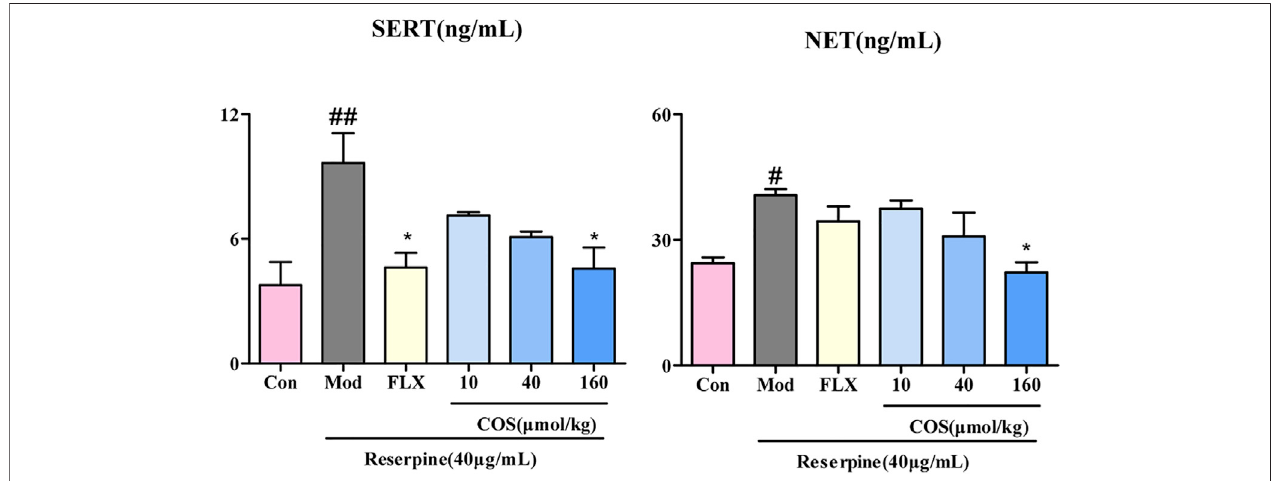
FIGURE7| Potentialmechanism ofthe antidepressanteffectofcostunolide(COS). Through inhibiting theexpression ofSERT and NET,COS inhibits thereuptake functionof5-HTandNEintheprocessofsynaptictransmission,toincreasethelevelof5-HTandNEandactivaterelated receptors, whichisthepotentialmechanismof its antidepressant effect. The Figure 7 was created with BioRender.com.